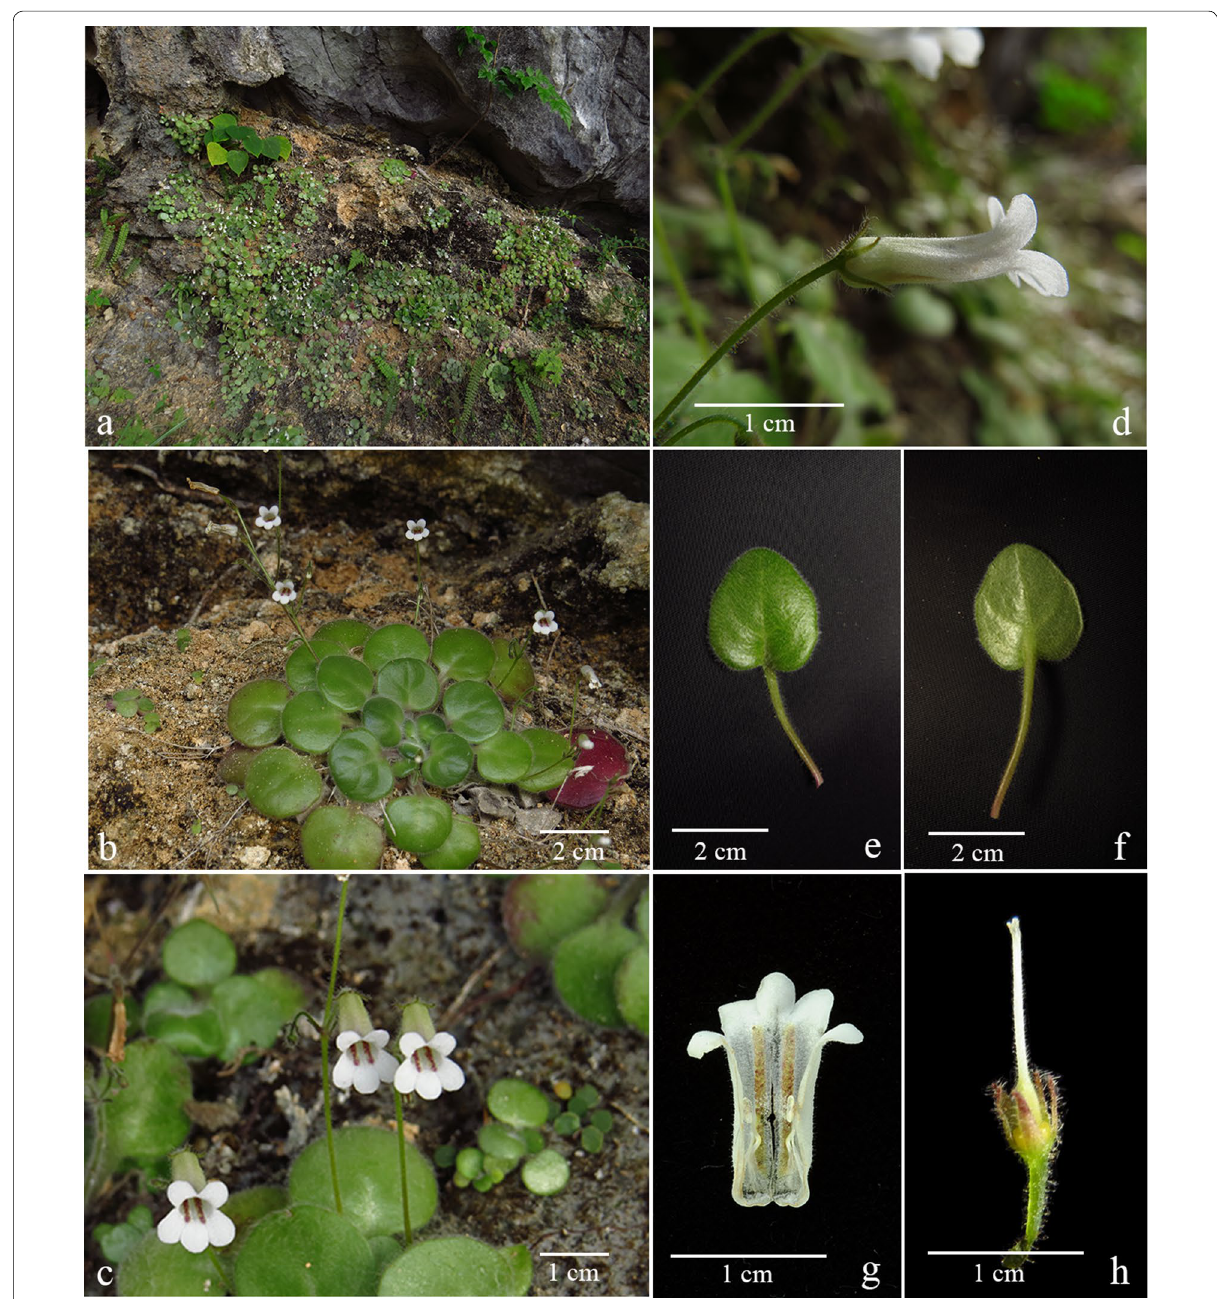
Fig. 12 Primulina chingipengii W.B.Xu & K.F.Chung. a habitat, b habit, c flower (face view), d flower (side view), e upper surface of leaf, f lower surface of leaf, g opened corolla showing stamens and staminodes, h pistil and calyx. All taken from type locality ( W. ‑ B. Xu et al . 13158